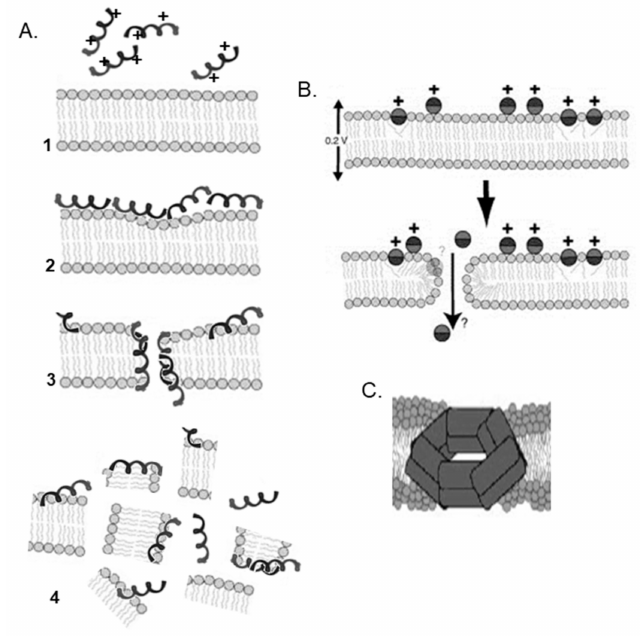
Figure 4. Different pore models. ( A ) Shai–Huang–Matsazuki (SHM) model [9]. ( B ) Electroporation model (reprinted from a previous paper [33], Copyright (2006), with permission from Elsevier). ( C ) Double-belt pore model (reprinted with permission from a previous paper [41]. Copyright (2014) American Chemical